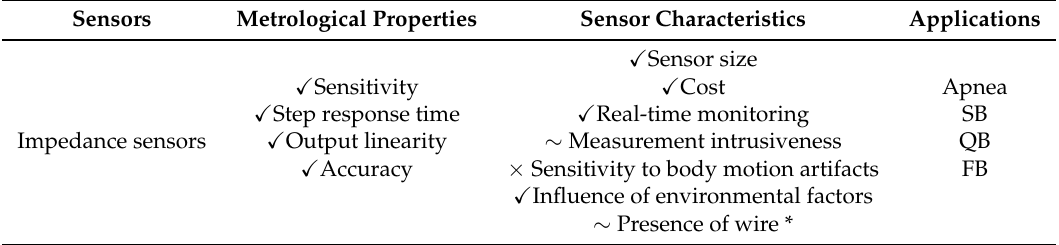
Table 7. Main metrological properties and characteristics of the impedance sensors used for f R measurement. (cid:88) good to excellent, ∼ sufficient, × poor.